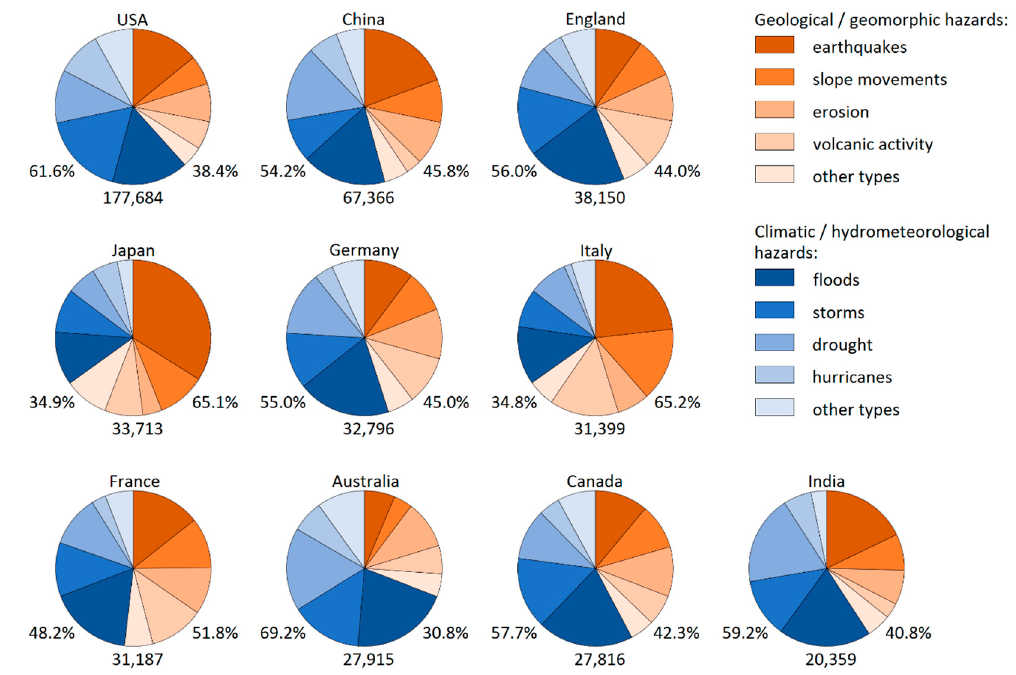
Figure 3. The share of major types of natural hazards among the top 10 research countries. The numbers show the total number of research items and the percentages show the share between research items dealing with the geological/geomorphic natural hazards and research items dealing with the climatic/hydro-meteorological natural hazards.